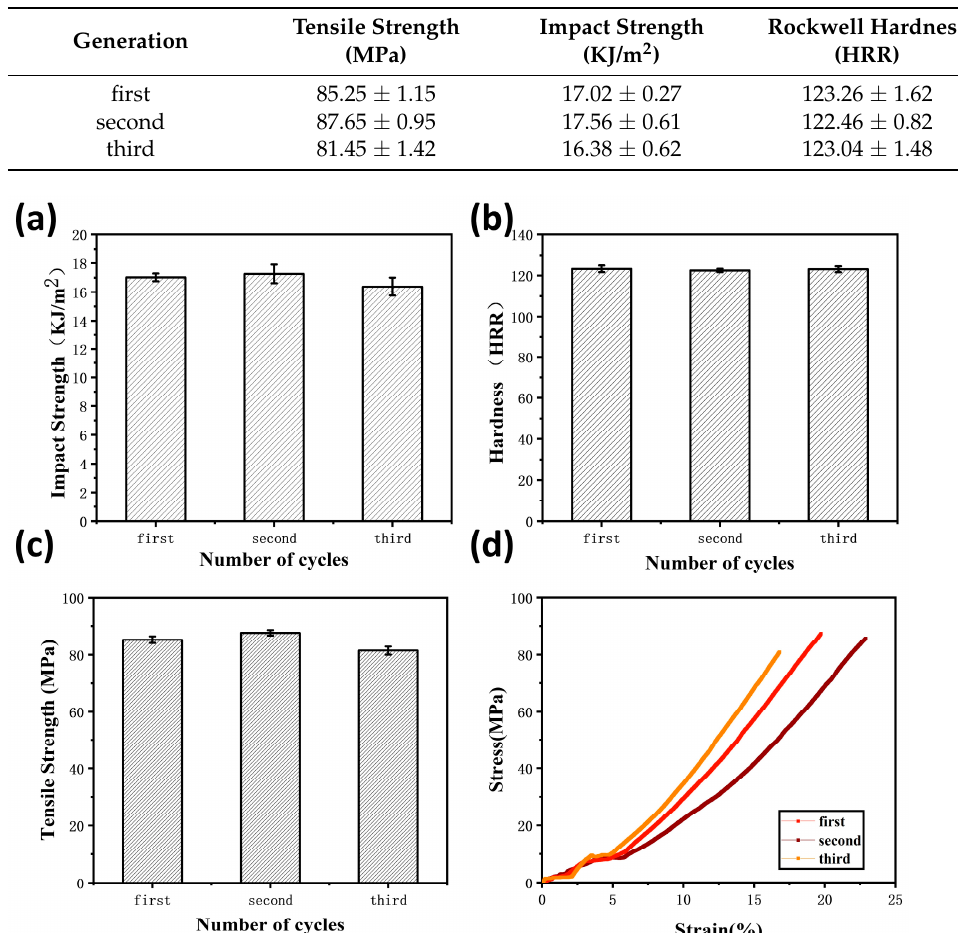
Figure 9. Impact strength ( a ), hardness ( b ), tensile strength ( c ) and stress–strain ( d ) of three genera- tions of MSiCw-1-MGO-0.3-PI